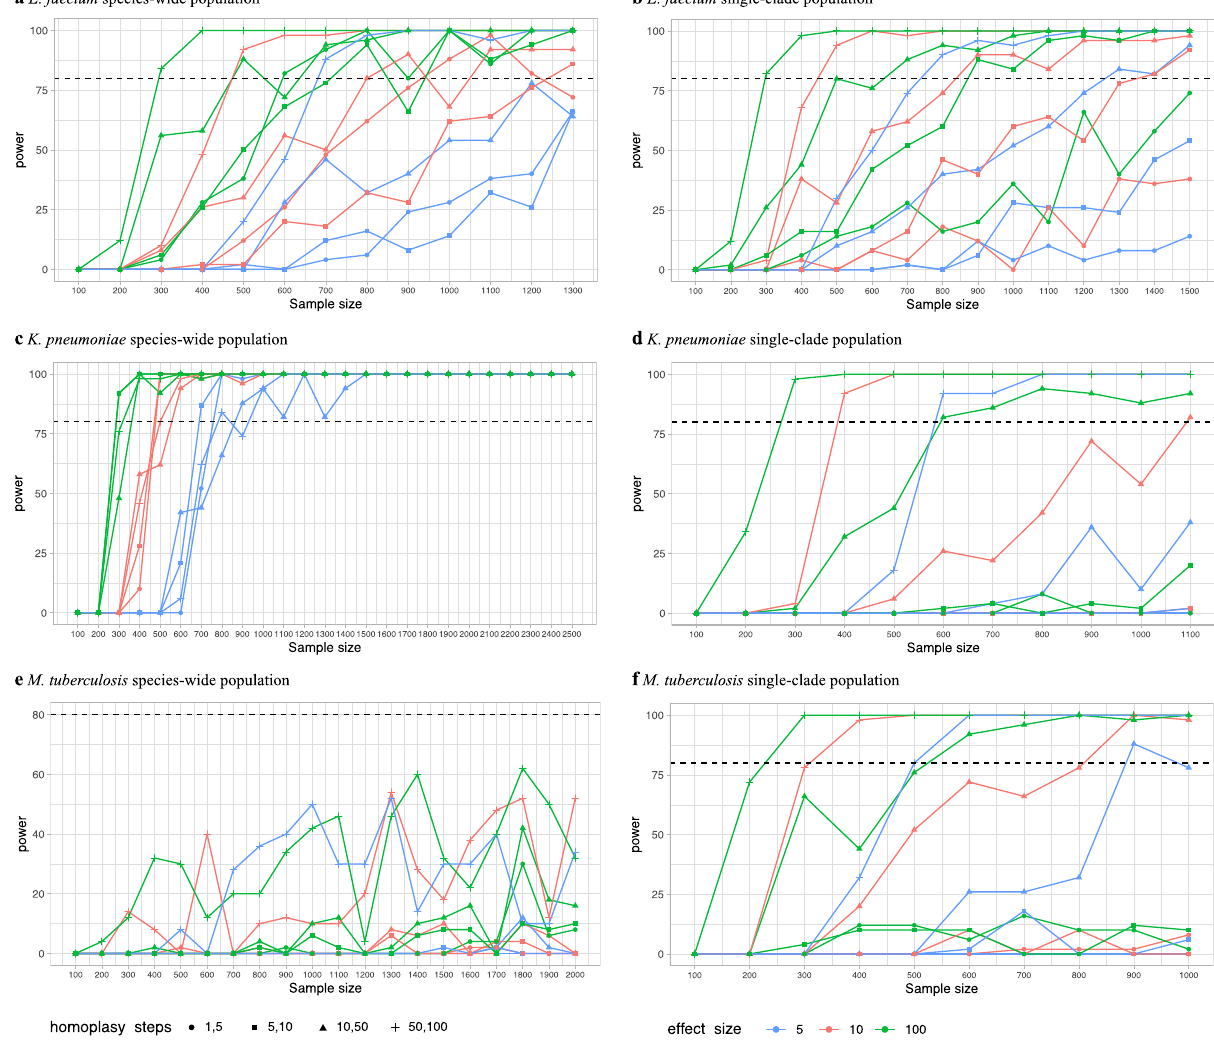
Fig. 3 Effect of degree of homoplasy on the power to detect SNPs obtained using the phenotype-simulation approach. These plots show the sample sizes required to detect causal SNPs of different effect sizes (in odds ratio units, showed as different colours) and degrees of homoplasy (number of independent acquisitions, shown as different point shapes) when simulating binary phenotypes (full heritability assumed). The power calculation results presented here are those for SNPs of 10% MAF, in both species-wide (panels a , c , e ) and single-clade populations (panels b , d , f ), see Supplementary Table 4 for SNPs of different MAF. The power in Fig. 3e, i.e. for SNPs with 50 – 100 homoplasy steps in M. tuberculosis population, are particularly noisy due to the low number of SNPs in this population arising 50 – 100 times in the phylogeny (only 9 variants), which makes power estimates of such a small sample to fl